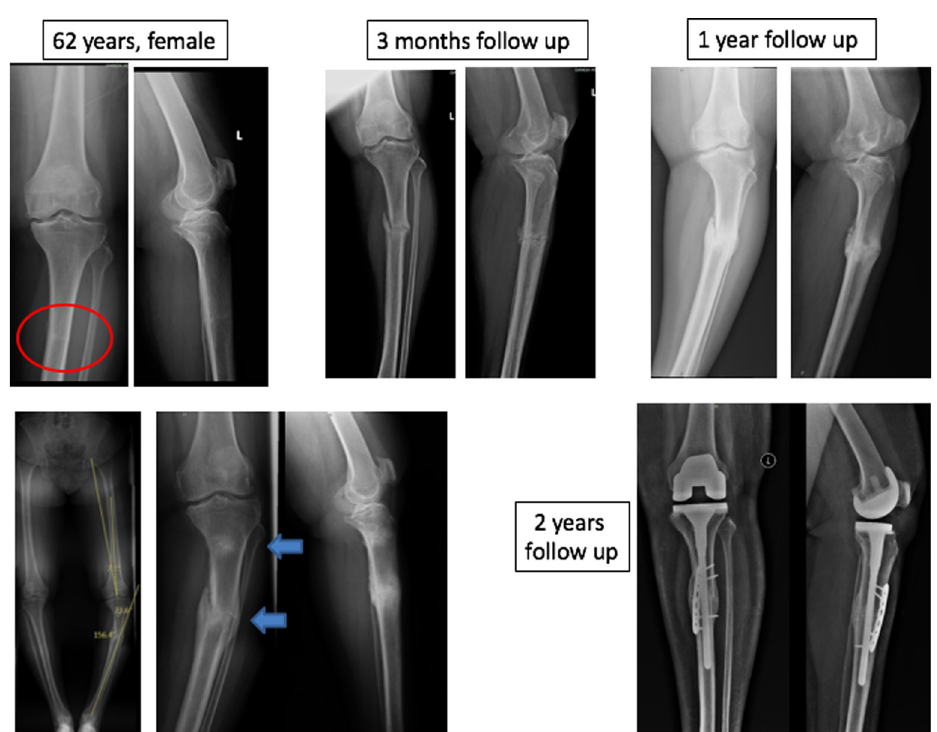
Figure 3. Two level stress fracture with malunion at stress fracture site treated with TKA with long stem augmented with plating and bone grafting.